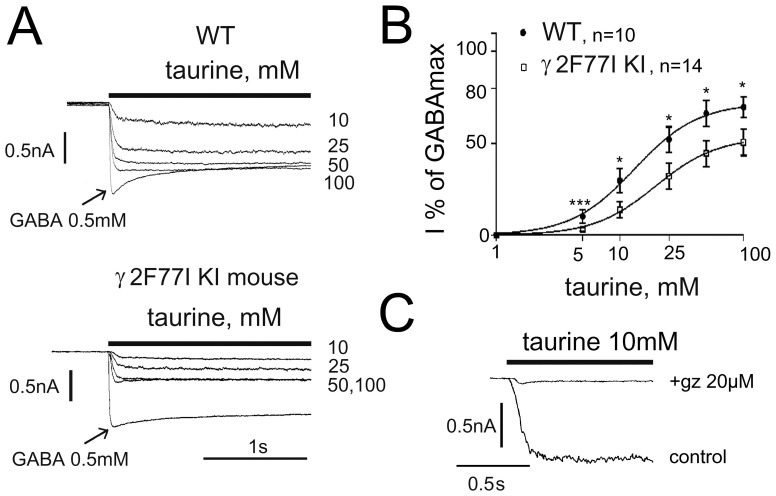
Gating of native GABAA receptors by taurine is impaired by the mutation γ2F77I.(A) Whole-cell voltage-clamp recordings (Vh = −50 mV) from adult WT or KI mouse TMN neurons isolated from hypothalamic slices. Taurine evokes maximal responses (at 50 and 100 mM) which are comparable in amplitude to the maximal GABA (0.5 mM)-evoked currents in wild-type (WT) mouse but represents only half of the GABA-response in the knock-in (KI) γ2F77I mouse. (B) Averaged concentration - response curves obtained from 10 WT and 14 KI neurons. Significant difference between individual data points is indicated: * p<0.05; *** p<0.005. (C) GABAAR- versus GlyR-involvement in taurine-responses was tested by the co-application of taurine with gabazine (gz, GABAAR antagonist). Amplitude of the remaining response was subtracted in each neuron from the control taurine response, to construct the concentration - response curves in (B).